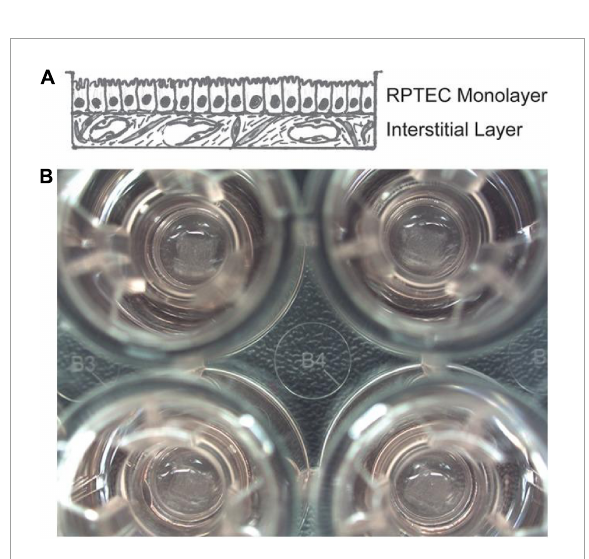
FIGURE7 The 3D model of the interstitial interface of the kidney tubule using 3D bio-printing. Panel (A) is a hand-drawn view of the supporting epithelial and multicellular interstitial layers. Panel (B) is a macro view of the 3D bio-printed proximal tubule tissue in the Transwell experiment on a 24-well plate